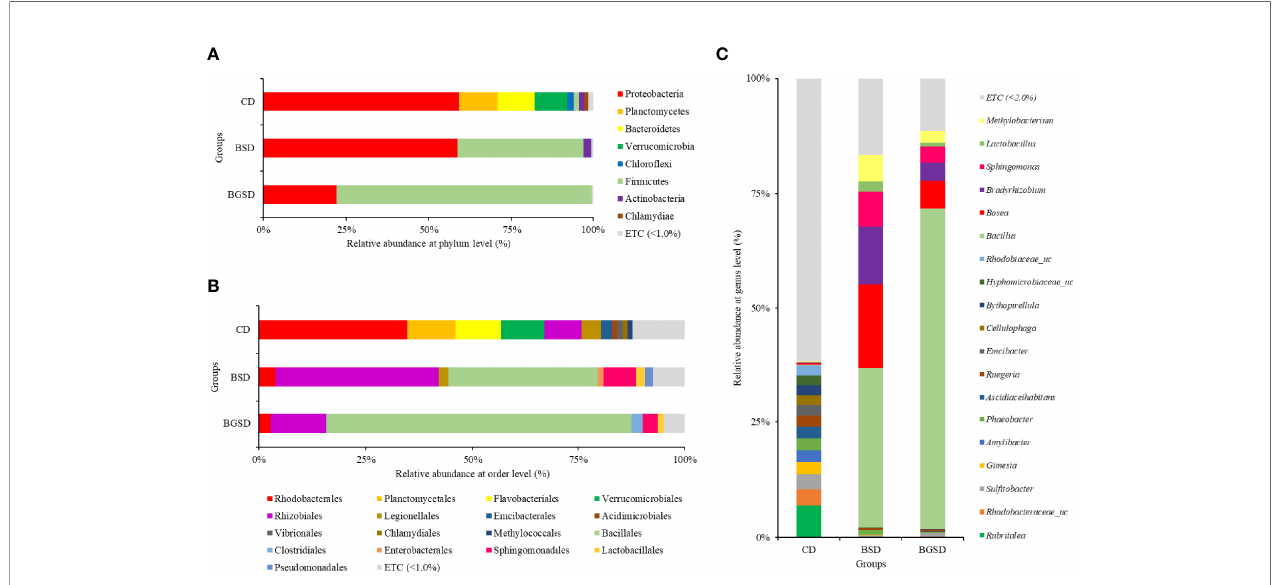
FIGURE 4 | Composition and relative abundance of intestinal bacterial communities of red sea bream with different diets at the phylum (A) , order (B) , and genus (C) level. Control diet, CD: without Bacillus sp. PM8313 or b -glucan, BSD: 1 × 10 8 CFU g − 1 Bacillus sp. PM8313, and BGSD: BSD + 0.1% b